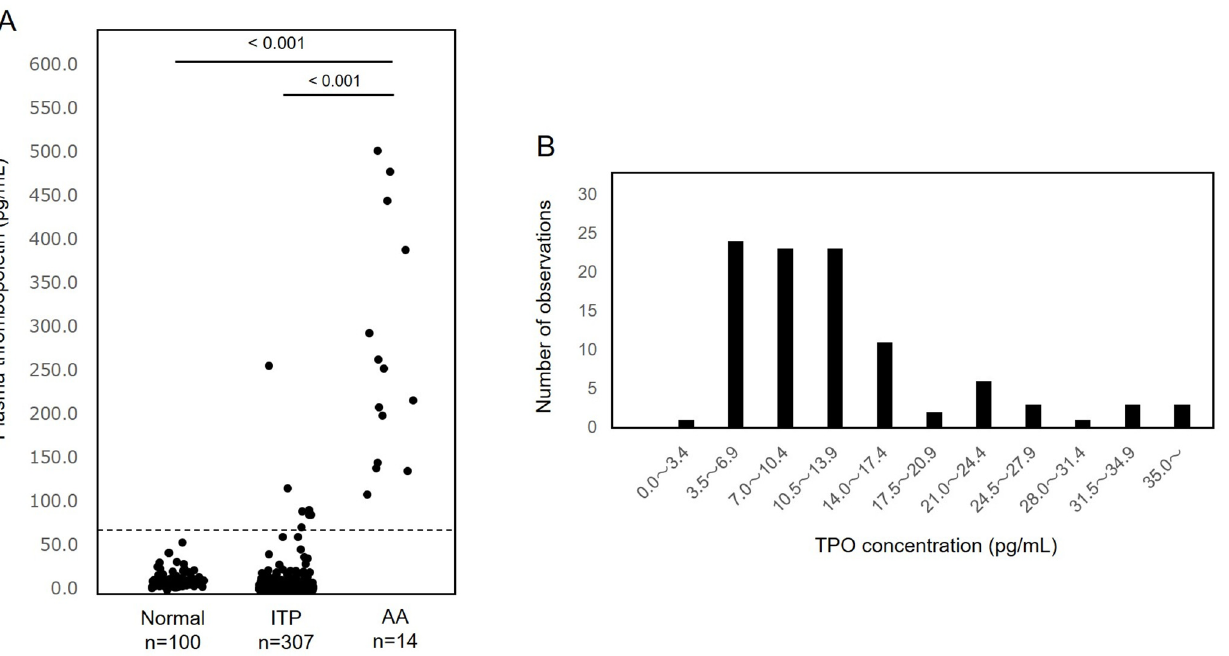
Figure 5. Clinical validation of TPO-CLEIA in study participants. ( A ) Plasma thrombopoietin (TPO) levels in healthy controls, patients with immune thrombocytopenia (ITP), aplastic anemia (AA). ( B ) Distribution of TPO concentrations in healthy controls.